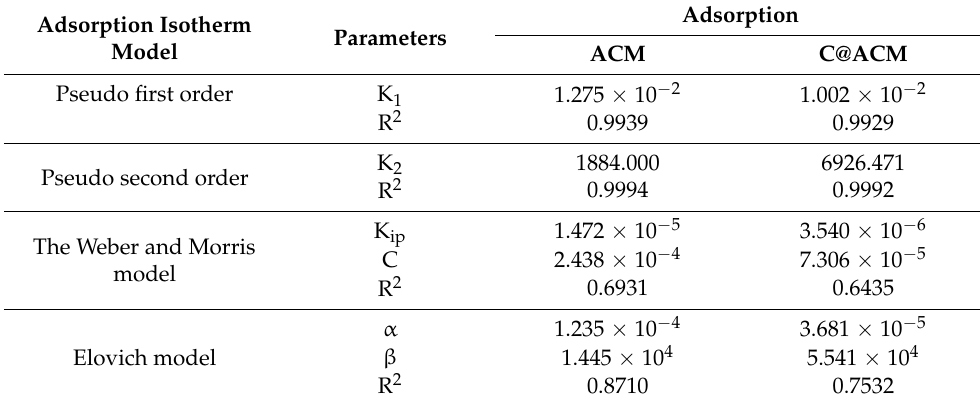
Figure 7. Adsorption kinetics of ACM and C@ACM: ( a ) pseudo-first order; ( b ) pseudo-second order; ( c ) the Weber and Morris model; ( d ) the Elovich model. Table 4. Kinetic parameters for H+